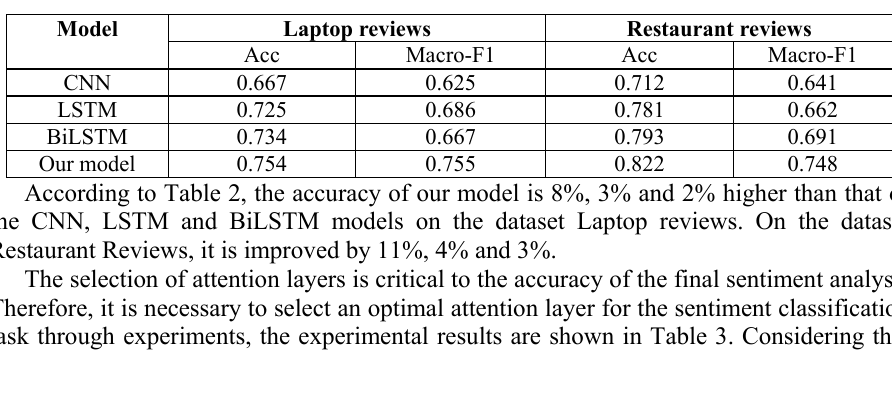
Table 2. Comparison of experimental